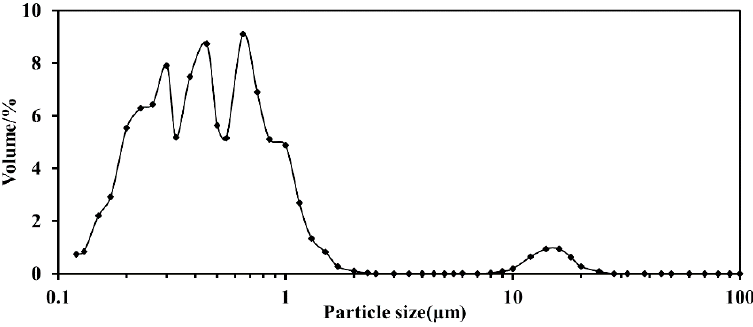
Figure 1. The particle size distribution of blank milk system.